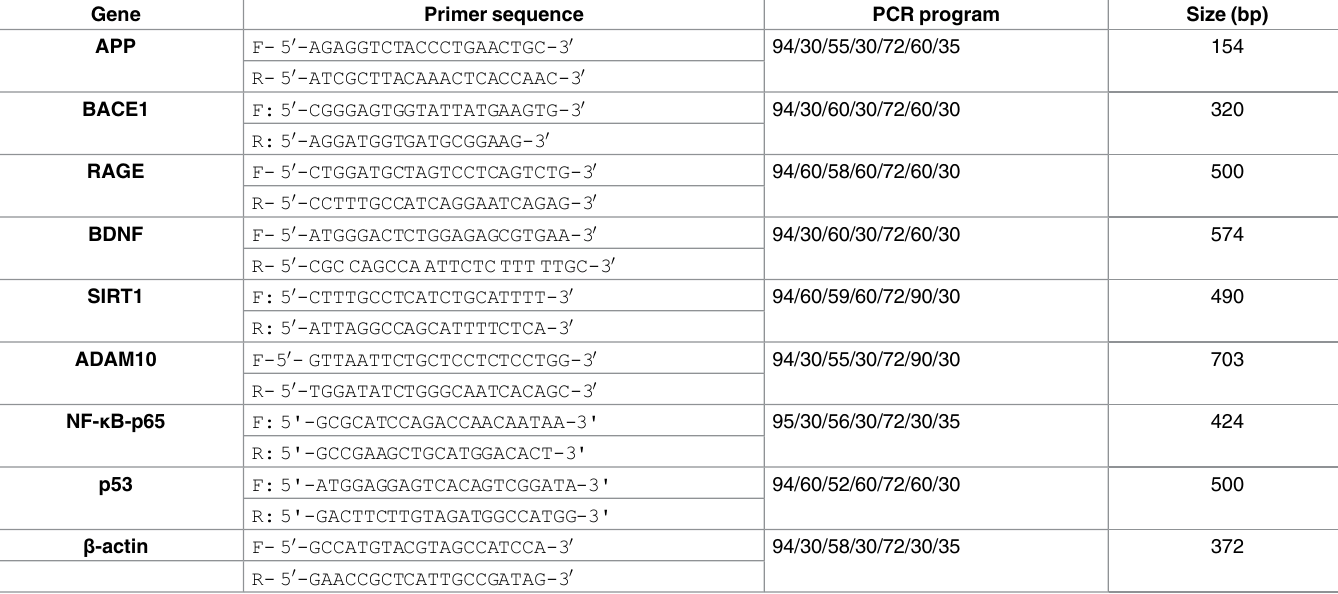
Table 1. Primer sequences and products size of target genes in expected PCR products for semi-quantitative RT-PCR.